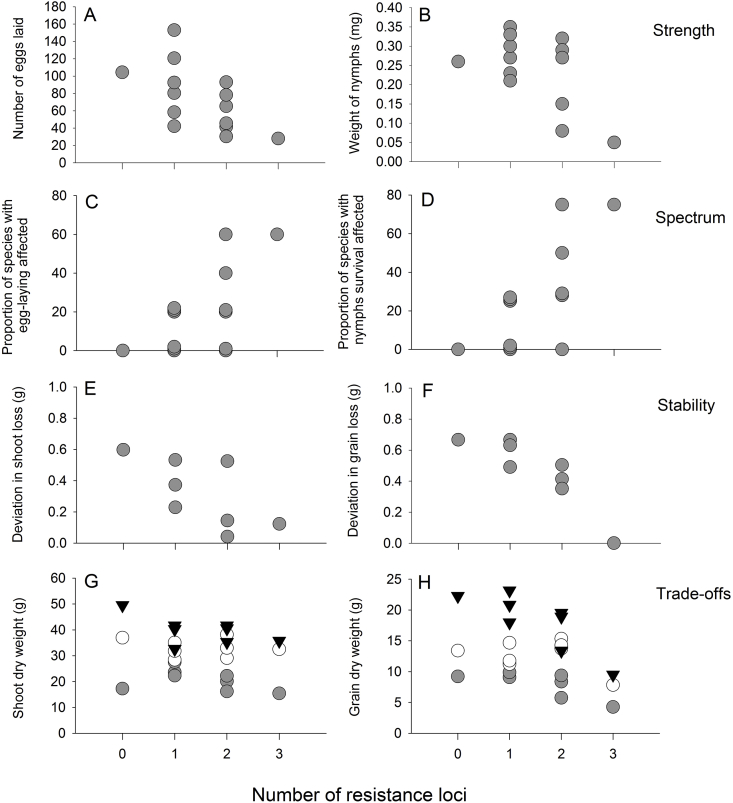
Correlations between the number of resistance loci in rice lines and A) the number of eggs laid by GLH, B) the weight of GLH nymphs after 10 days on rice seedlings, C) the proportion of hopper species with significant reductions in egg laying (from a total of 4 species), D) the proportion of hopper species with<50% nymph survival on rice seedlings (from a total of 5 species), E) the mean deviation from zero loss (= no loss, based on control) of shoot biomass in plants infested with GLH across a nitrogen gradient ([[shoot loss at 150 Kg N ha−1 – shoot loss at 60 Kg N ha−1] + etc.]/3); F) the mean deviation from zero in grain loss across a nitrogen gradient ([[grain loss at 150 Kg N ha−1 – grain loss at 60 Kg N ha−1] + etc.]/3); G) The weight of shoots under benign conditions; and H) the yield of plants under benign conditions. Shaded symbols in G and H = 0 Kg N ha−1, open symbols = 60 Kg N ha−1, black symbols = 150 Kg N ha−1.